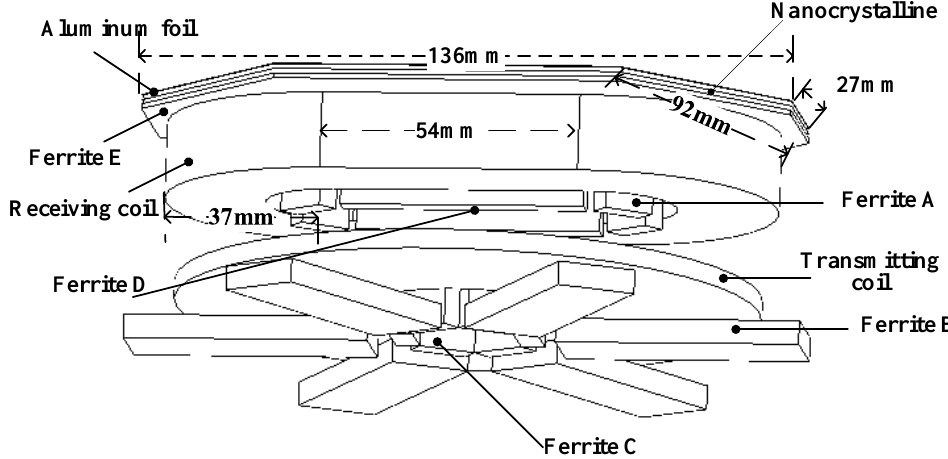
Figure 5. A 3D structure model of magnetic coupling for the small fruit and vegetable juicer.